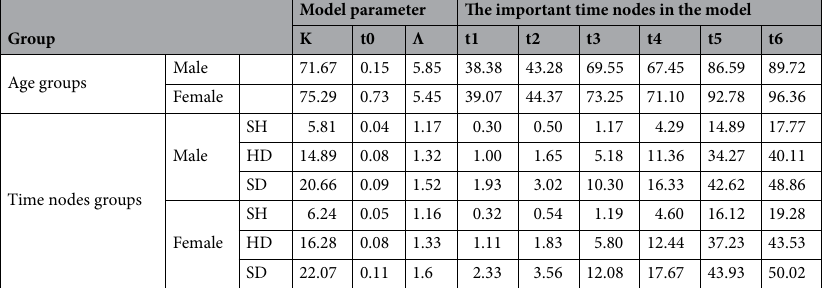
Table2. The calculation results of model parameters and import time nodes. SH: the length of the symptom time to hospitalization date; HD: the length of the hospitalization date to death time; SD: the length of the symptom time to death time. t0: the location parameter; k: the shape parameter; λ: the scale parameter. t1 = T. lower 97.5% CI, t2 = T.lower 95% CI, t3 = T.peak, t4 = T.median, t5 = T.upper 95% CI and t6 = T.upper 97.5%CI.